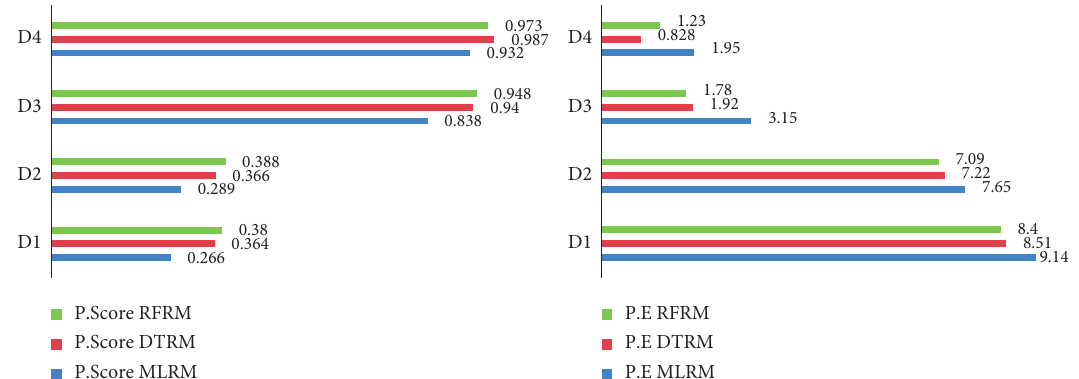
Figure 13: The performance measure of MLMLR, DTR, and RFR machine learning models.